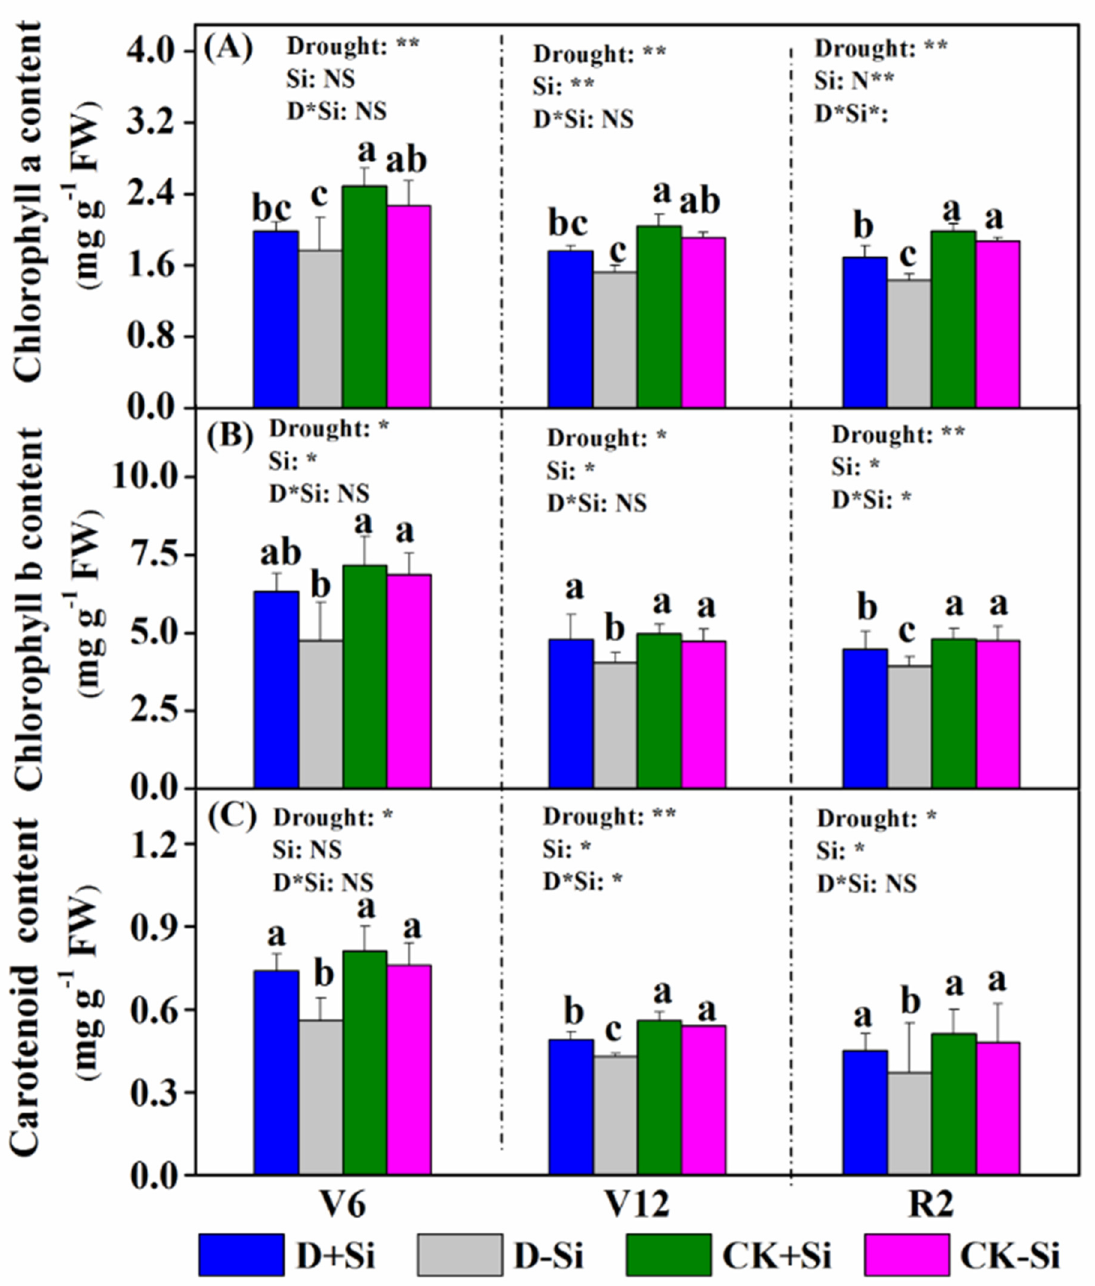
Figure 4. Effect of Si application on chlorophyll a ( A ), chlorophyll b ( B ), and carotenoids ( C ) content in maize leaves at the V6, V12, and R2 stages under drought and control conditions. V6, the 6-leaf stage; V12, the 12-leaf stage; R2, the blister stage; +Si, Si addition; -Si, no Si addition; D, drought stress; CK, well-watered control conditions. Data are the means ± standard errors (SE) of three replicates, where n = 3 for chlorophyll content. Different letters (a, b, c) above the bars indicate statistical significance ( p ≤ 0.05). ** Significant at p ≤ 0.01; * significant at p ≤ 0.05; NS, no significant difference.